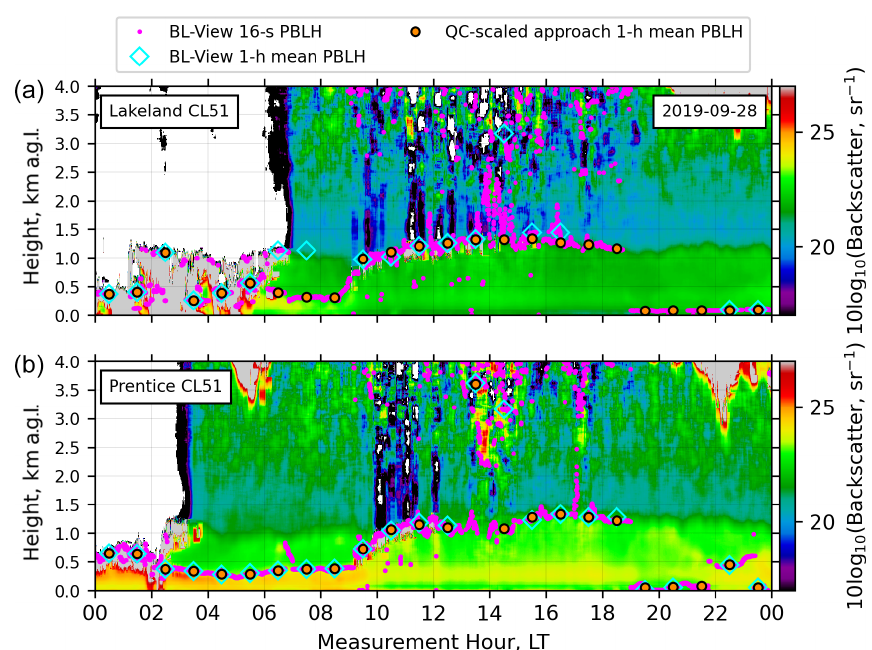
Figure 5. Time–height cross section of backscatter profiles at the Lakeland (a) and Prentice (b) sites for 28 September 2019. In both panels the magenta dots are the 16s temporal resolution PBLH estimates by the BL-View software, the cyan diamonds are the corresponding hourly mean estimates from the BL-View software, and the orange dots are the PBLH estimates obtained using the QC-scaled approach.